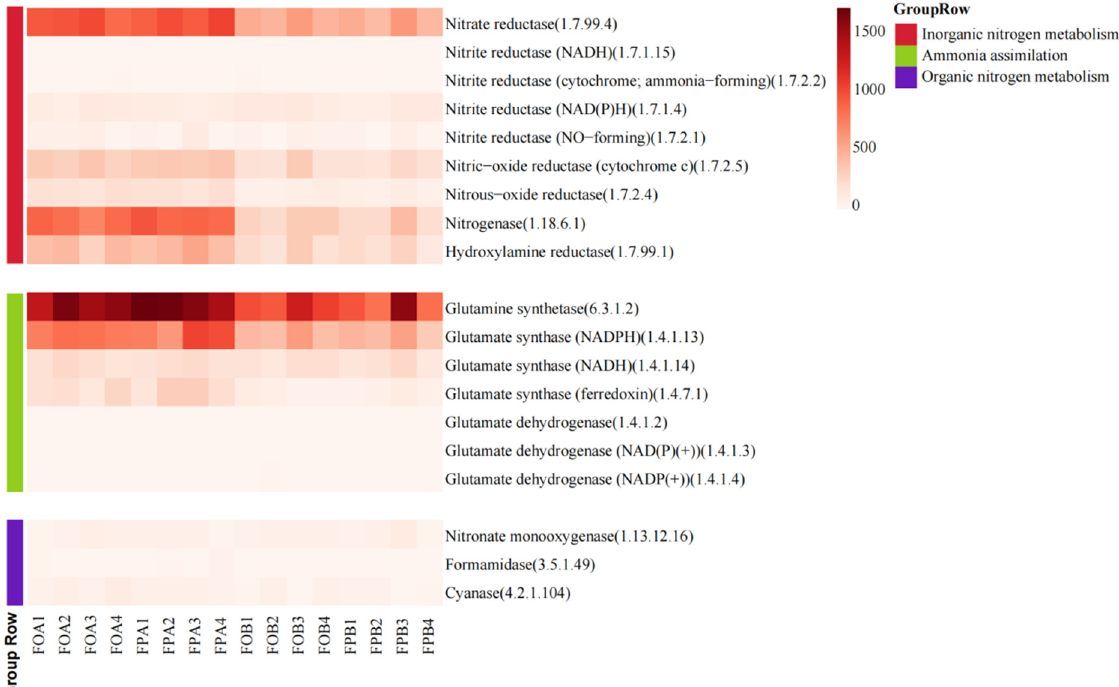
Figure 3. The heat map shows the proportion and abundances of enzyme families involved in the nitrogen cycle in the ponds’ sediments. The results of enzyme abundance in the figure were obtained by comparison with the ENZYME database. The number behind the enzyme is the EC number of the enzyme. The same is true